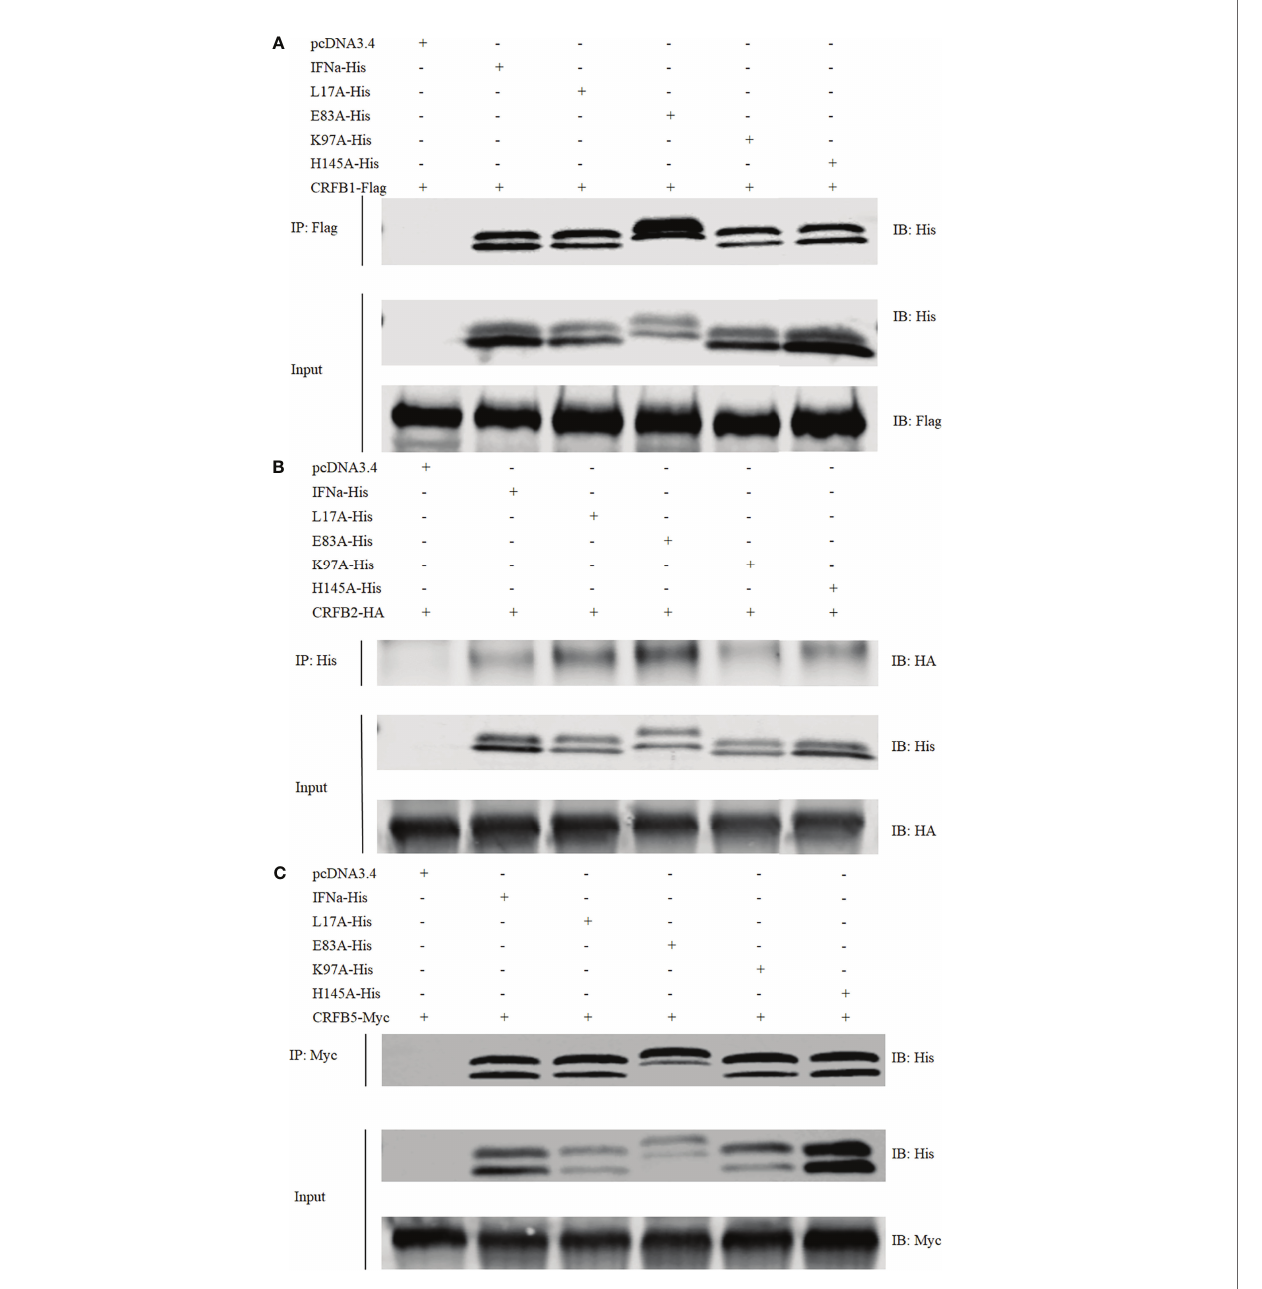
FIGURE 7 | Ci IFNa and mutants binds to CRFB1, CRFB2, and CRFB5. The HEK293 cells were transfected with respective plasmids (2.5 m g each). After 24 h, cell lysates were immunoprecipitated (IP) with antibody agarose resin. The immunoprecipitates and cell lysates were analyzed by immunoblotting (IB) with the anti-His, anti-Flag, anti-HA, or anti-Myc Abs. (A – C) Interaction of CiIFNa and mutants with CRFB1 (A) , CRFB2 (B) and CRFB5 (C) . "+"=transfected, "-"=not